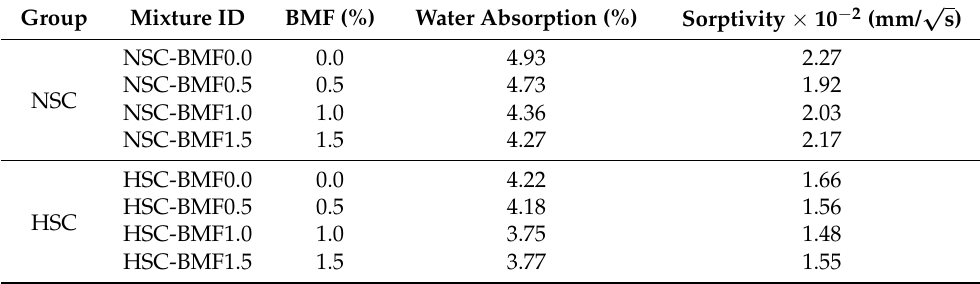
Figure 15. Water absorption versus BMF volume fraction relationship. Table 9. Water absorption and sorptivity test results.